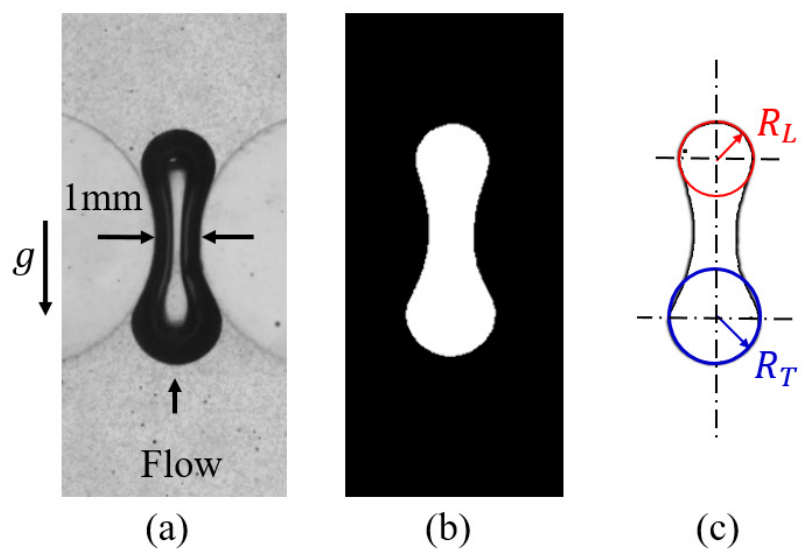
Figure 5. An example of ( a ) a raw image, ( b ) the isolated dispersed phase, and ( c ) processed image defining the leading and trailing geometry.